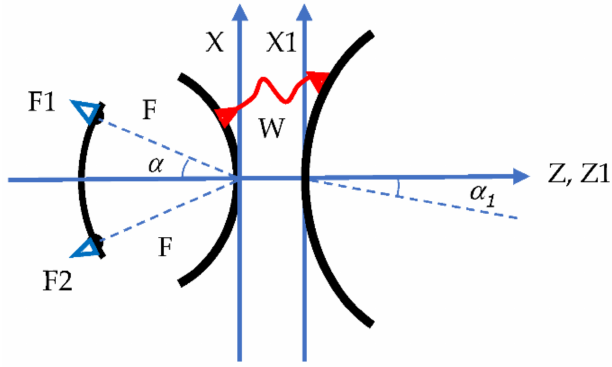
Figure 1. Variables defining a two-dimensional constrained